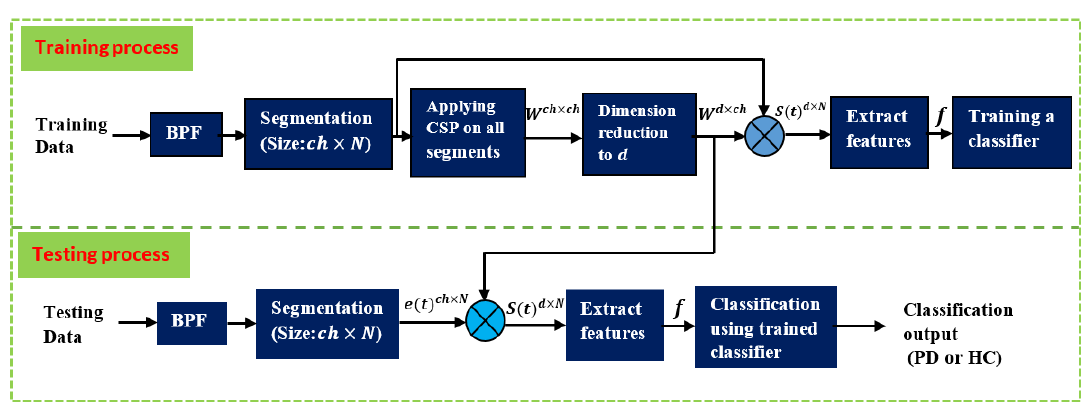
Figure 4. Summary of the processing and classification stages for the training and testing phases.